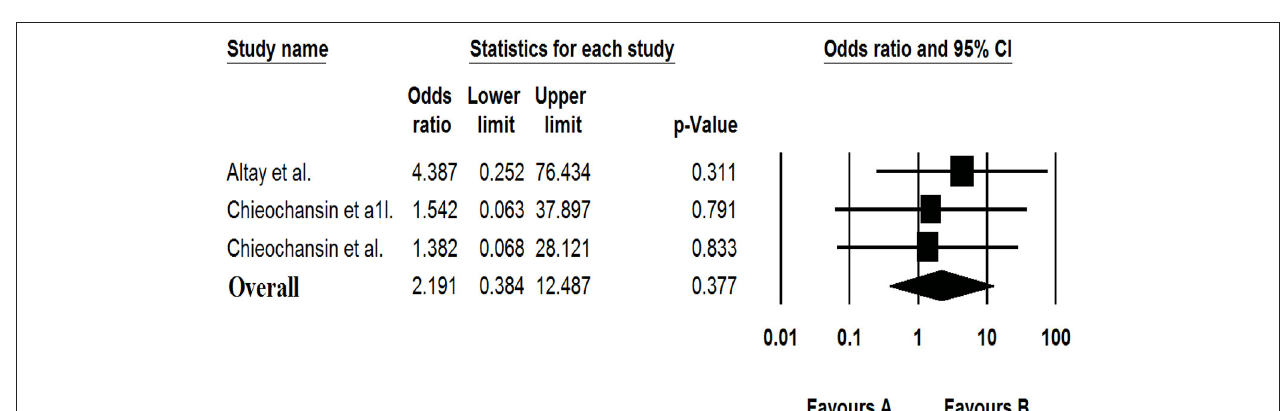
FIGURE 3 | Forest plot of odds ratios for the BuV based on case-control studies.